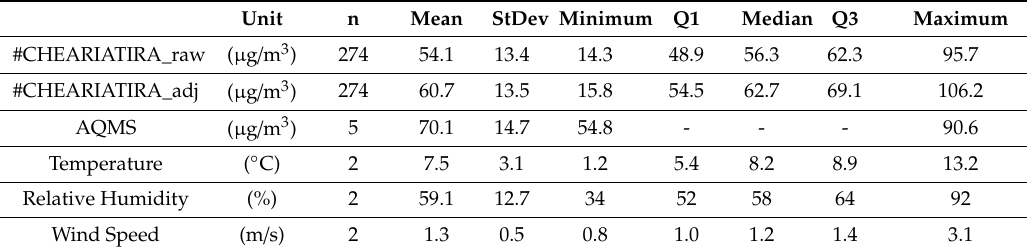
Figure 6. Map of NO 2 concentrations by “Circoscrizioni” for the campaign period.